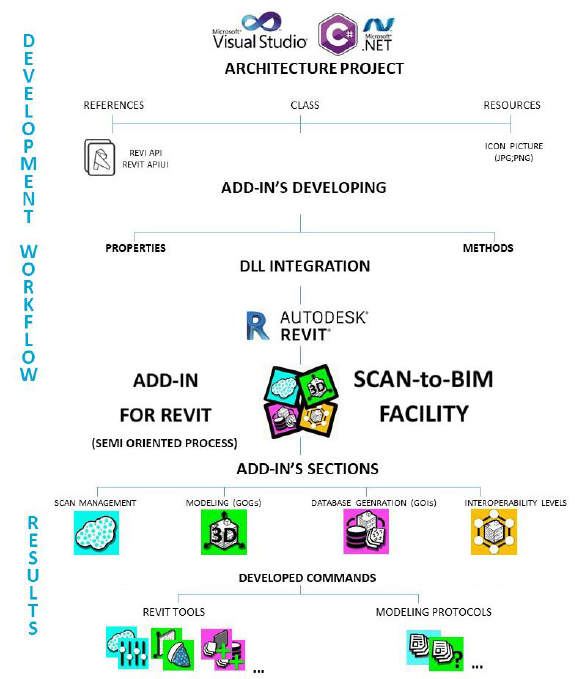
Figure 1.Revit add-in’s development